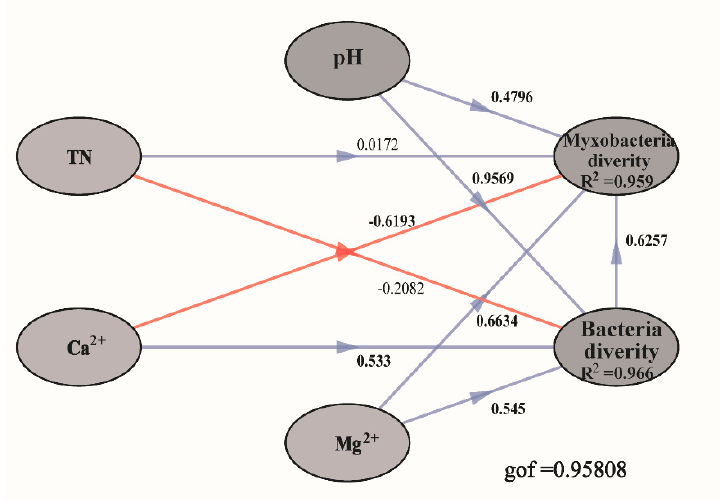
Figure 7. Structural equation models (SEMs) showing the effects of pH, total nitrogen (TN), Calcium ions (Ca 2+ ), Magnesium ions (Mg 2+ ), and bacterial diversity on myxobacteria diversity. Values on the arrows represent the path coefficients. Red and blue lines indicate the significant ( p < 0.05) and non-significant ( p > 0.05) relationships, respectively. The “gof” indicates the goodness of fit. R 2 denotes the proportion of variance explained. Bacterial and myxobacteria community diversity is represented using α -diversity indices (Observed OTU richness, Chao1, and Shannon).